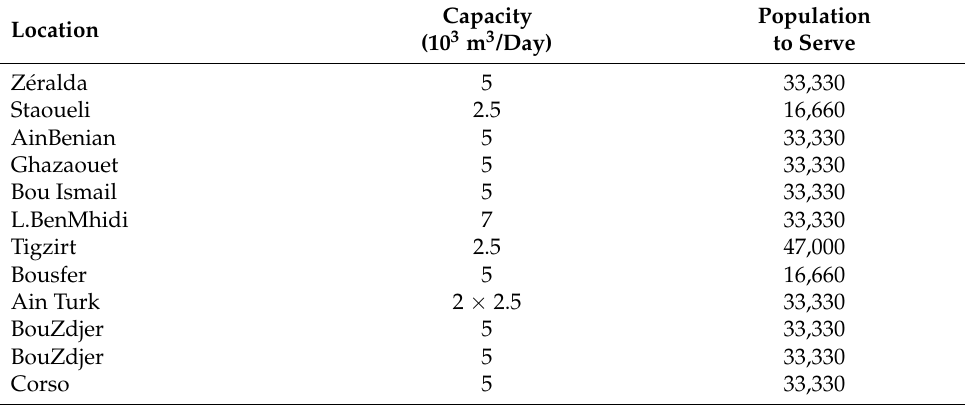
Table 8. Mono-block SWRO plants installed along the coastal areas of